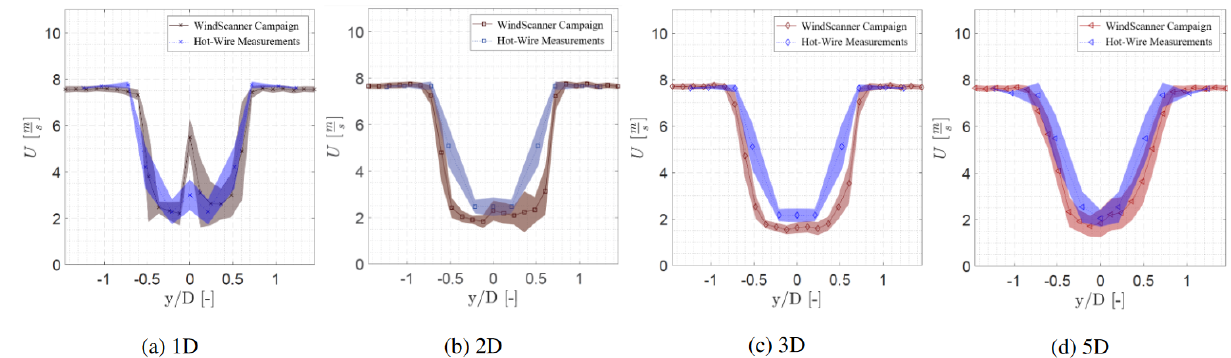
Figure 13. Comparison of the profiles of the averaged streamwise velocity component at 1, 2, 3, and 5 D between the WindScanner measure- ments and the hot-wire measurements at Neunaber (2019). Both measurements were conducted with no grid at U = 7 . 5ms − 1 . The shaded area shows the ± σ of the measurement data.